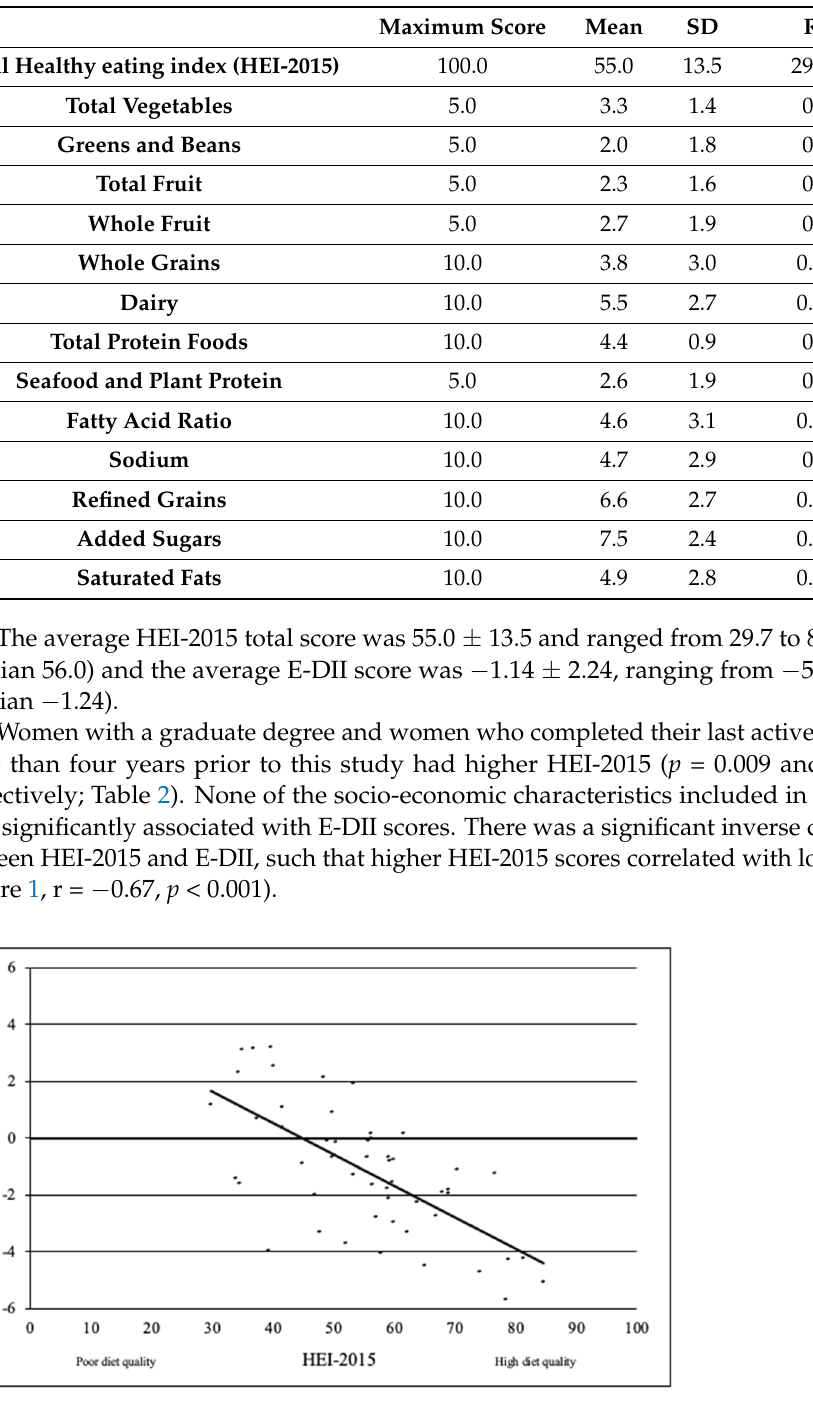
Figure 1. Correlation between Energy-Adjusted Dietary Inflammatory Index (E-DII) scores and Healthy Eating Index (HEI-2015) scores in women’s cancer survivors (n 52). Healthy Eating Index (HEI-2015) scores in women’s cancer survivors (n =